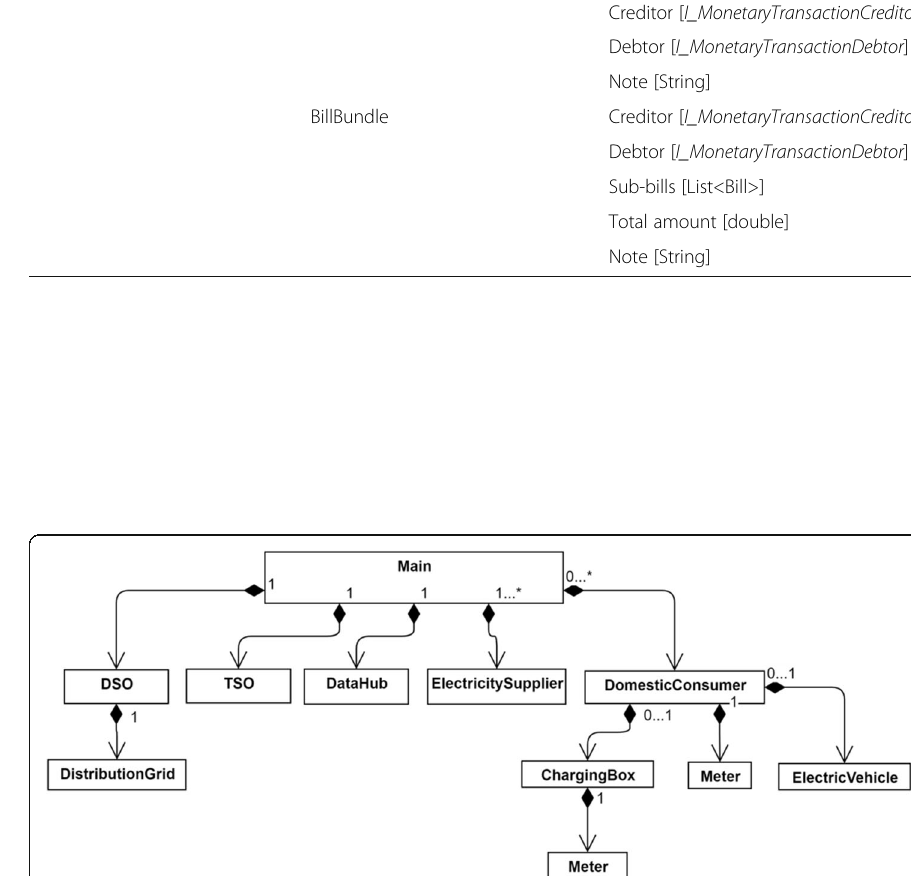
Fig. 11 Agent type architecture of the case study